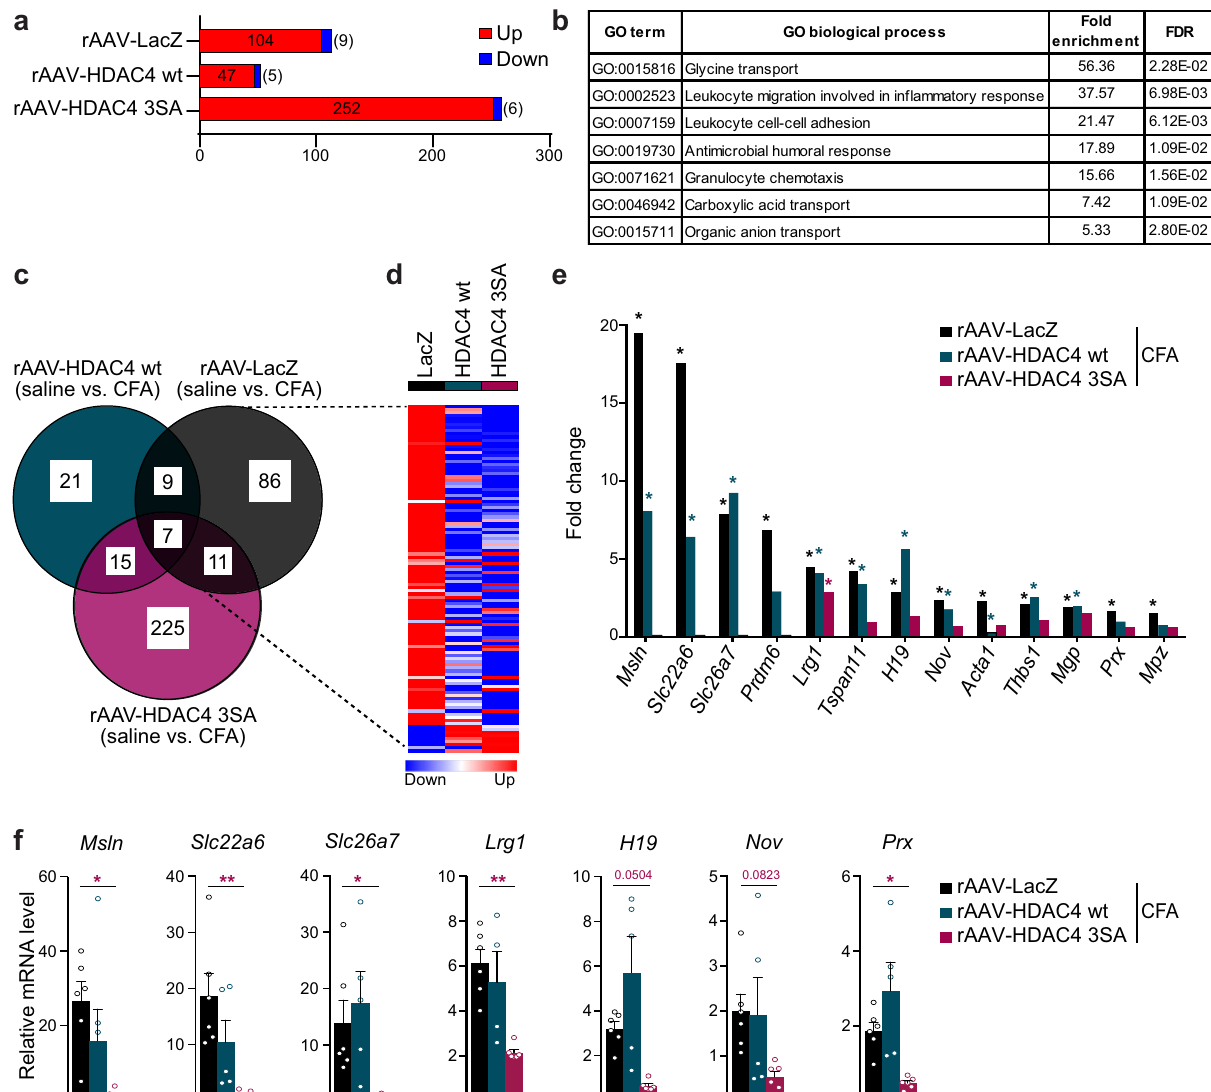
Fig. 3 HDAC4 regulates gene expression in persistent in fl ammatory sensitization in the spinal cord. a Number of differentially expressed genes (DEGs) ( p adjusted < 0.05), identi fi ed by RNAseq analysis, in the dorsal spinal cord (L3 – 5) of mice intra-spinally injected with either rAAV-LacZ, -HDAC4 wt, or -HDAC4 3SA that are signi fi cantly up- or downregulated following intraplantar injection of CFA ( n = 3 mice/group). b Gene ontology (GO) analysis of DEGs that are signi fi cantly up- or downregulated following CFA injection in LacZ-expressing mice, using the PANTHER overrepresentation test and database. Enriched GO terms with an enrichment score >5 are listed. c Venn diagram illustrating the number and overlap of signi fi cantly up- or downregulated DEGs following CFA injection, as in ( a ). d Heat map of the relative fold change of signi fi cantly DEGs in LacZ-expressing mice after CFA injection compared to the fold changes of the same genes in rAAV-HDAC4 wt or -HDAC4 3SA injected mice. Color-coding is adjusted per row. e Relative Asterisks refer to the statistical values provided in Supplementary Table 1. f Relative expression fold changes from QRT-PCR validation analysis